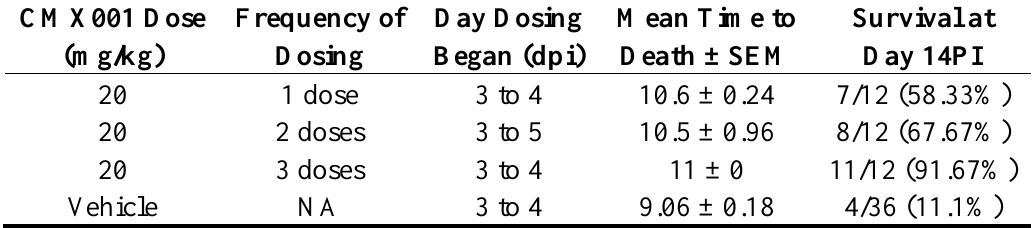
Table 2. Evaluation of efficacy of CMX001 when treatment is begun at the appearance of secondary lesions in the ears. Groups of 12 animals were treated with CMX001 1, 2 or 3 times every other day beginning at the appearance of secondary lesions in the